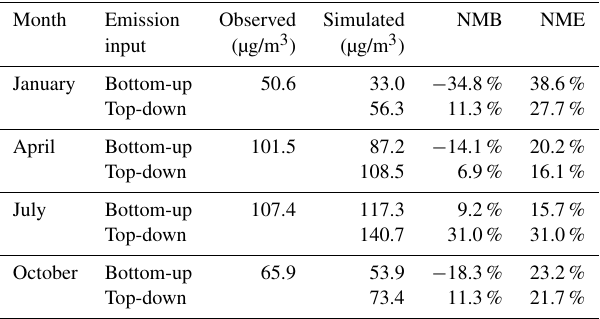
Table 1. The model performance statistics of daily maximum 8h averaged (MDA8) O 3 concentrations in January, April, July, and October 2016 with the bottom-up and top-down NO x emissions. Month Emission